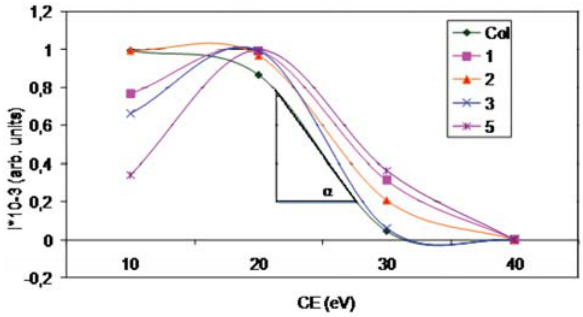
Fig. 4. Precursor ion [ M+H ] + ( Col , 1 , 2 , 3 , 5 ) abundance break- down plot against collision